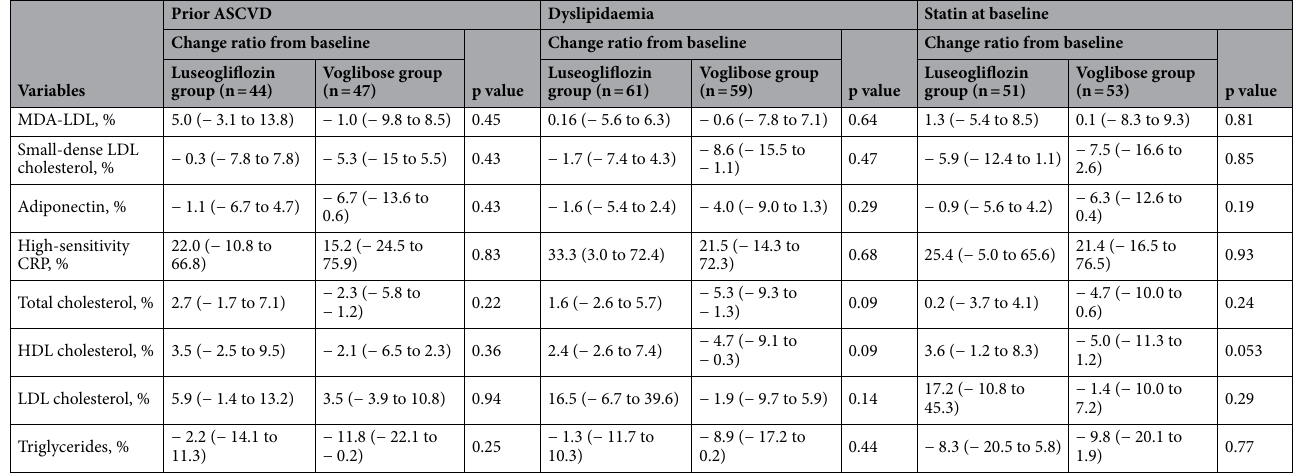
Table 4. Change ratio in biomarkers in patient subgroups with prior ASCVD, dyslipidaemia, and statin treatment at baseline. Data are presented as the mean (95% confidence interval). ASCVD